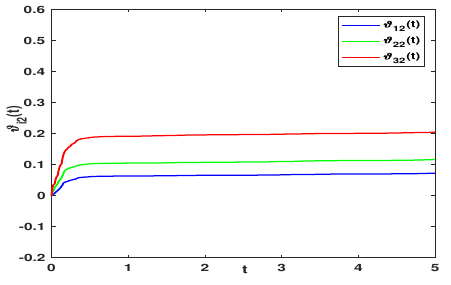
Figure 8. The adaptive laws ϑ i 2 ( t ) .